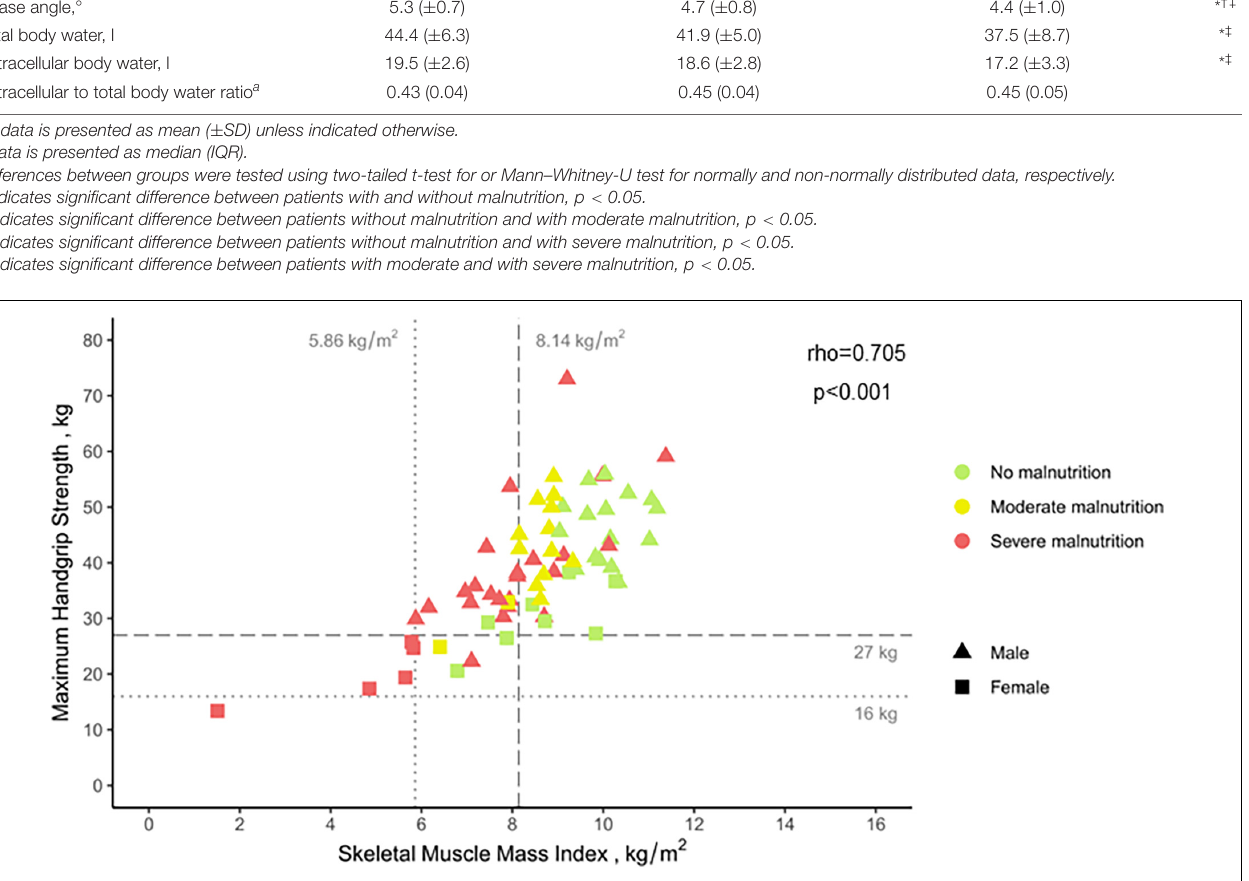
FIGURE 2 | Correlation between skeletal muscle mass index and maximum handgrip strength in patients with chronic pancreatitis. Data is presented stratified by nutritional status and sex. Vertical and horizontal lines indicate sex-specific thresholds of sarcopenia for skeletal muscle mass and handgrip strength, respectively. Spearman’s correlation coefficient was calculated to measure the strength and direction of association between the two